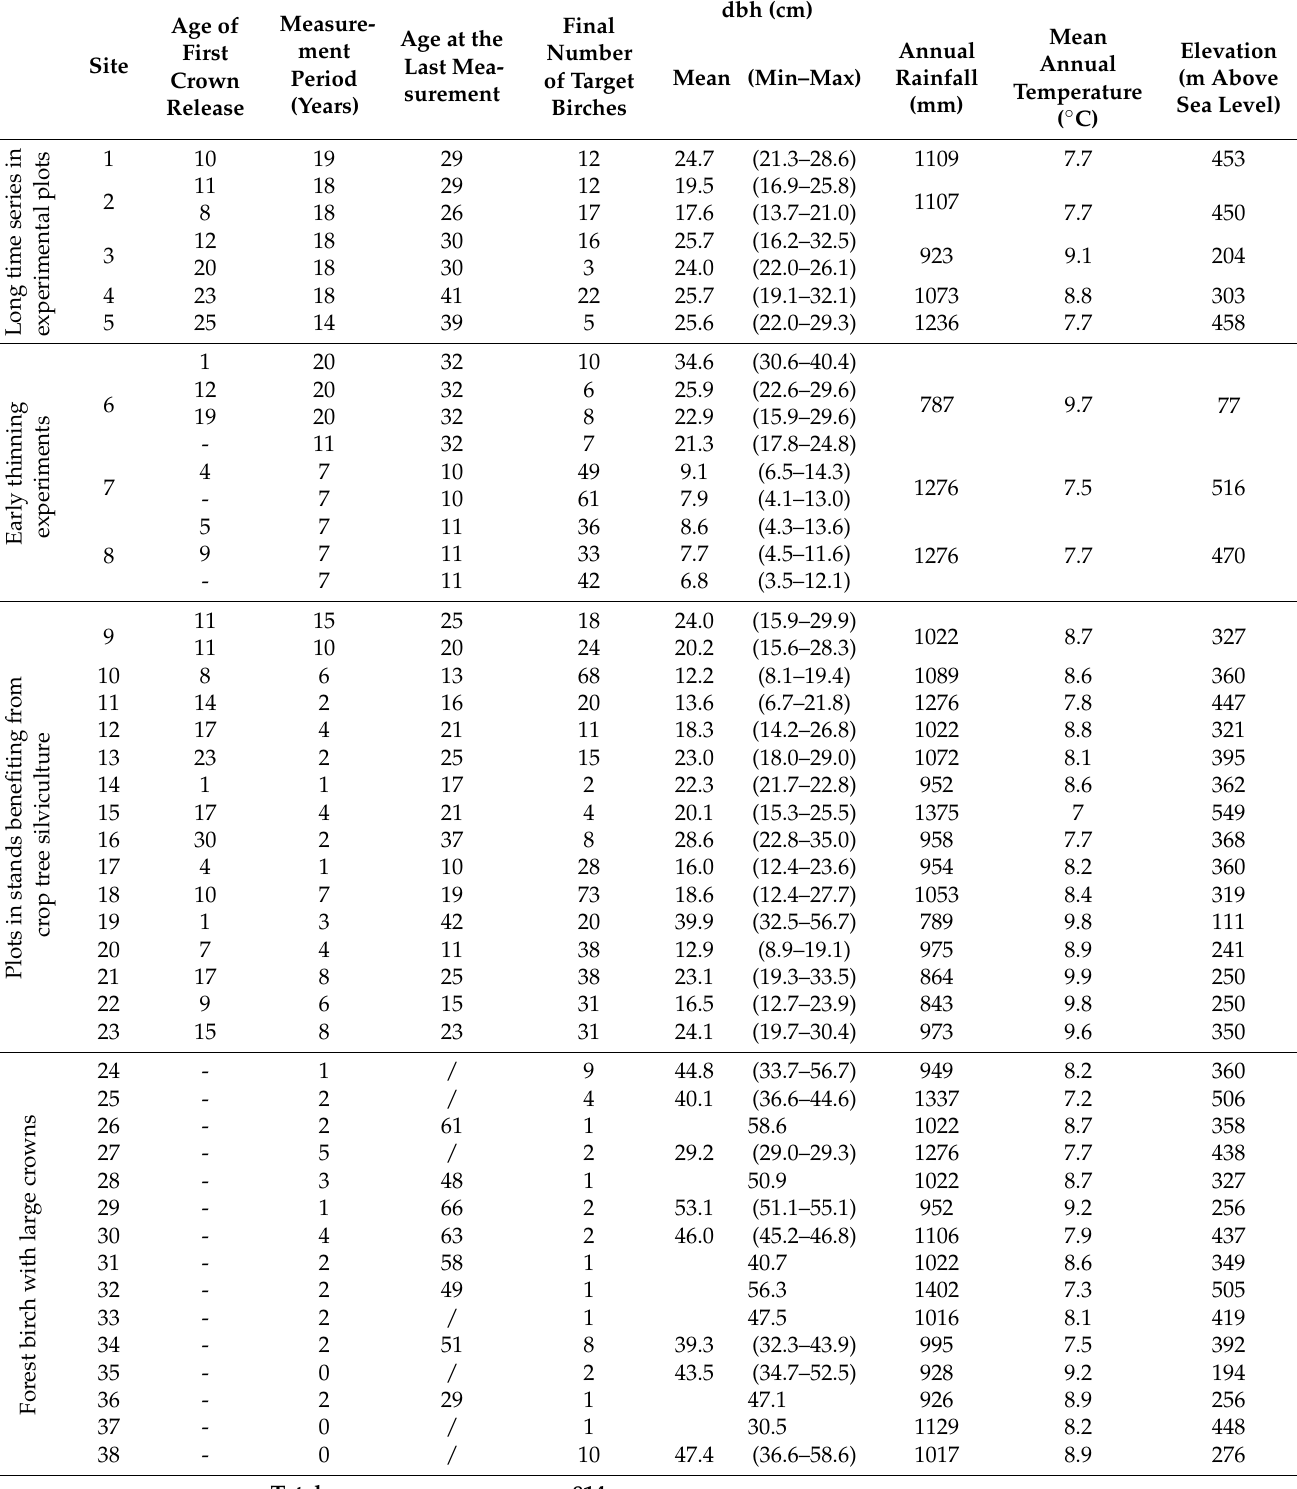
Table 1. Description of the monitoring period, silvicultural treatment (age of first crown release) and ecological conditions of each plot. For each plot is also given the final number of monitored target trees together with the mean, minimum and maximum dbh at the last measurement. In cases of heart decay, the number of tree rings could not be counted and so tree age could not be